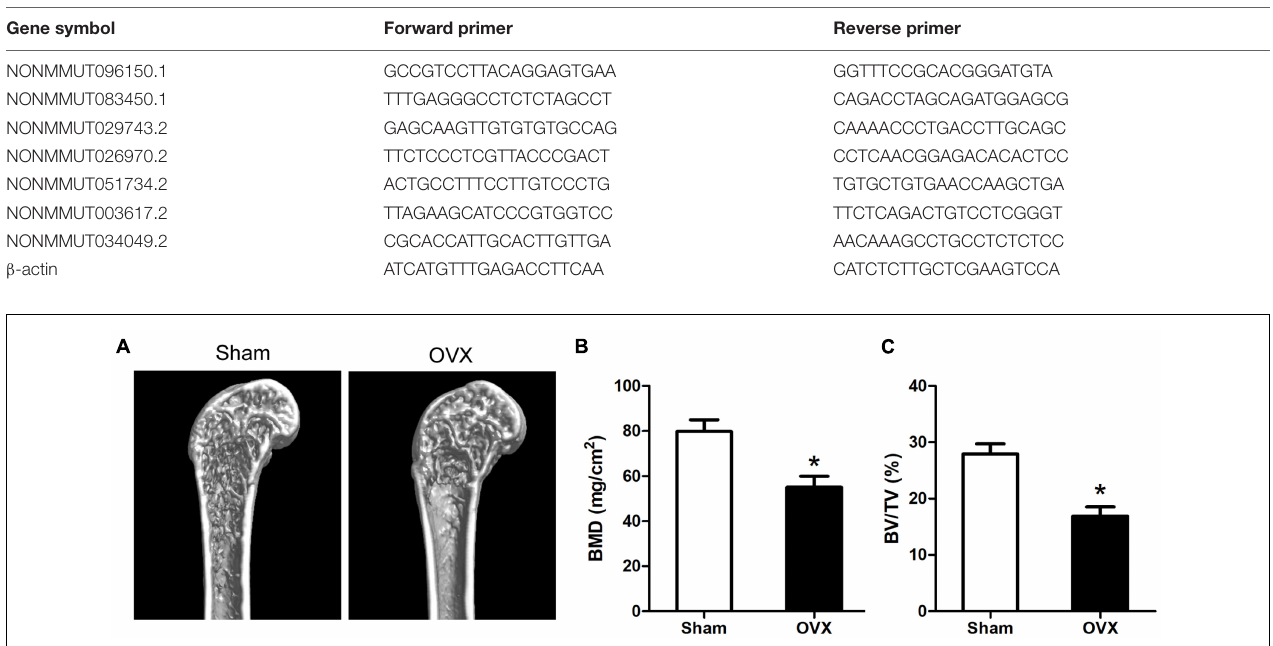
TABLE 1 | Primers for qRT-PCR in the experiment.